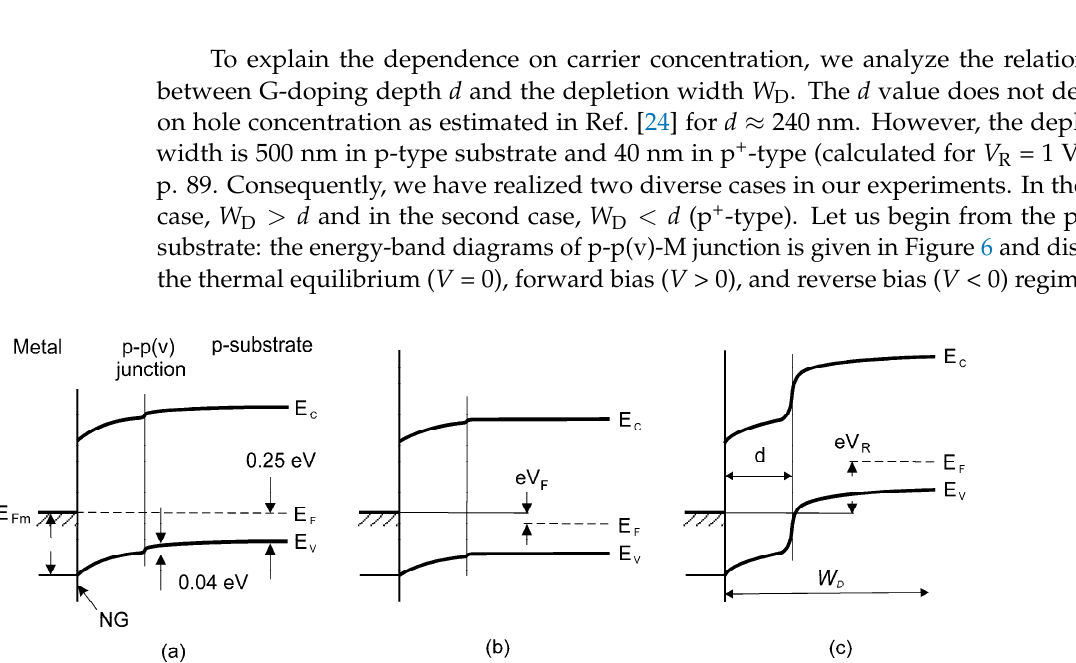
Figure 6. Energy-band diagram of p-p(v)-M junction: ( a ) thermal equilibrium; ( b ) forward bias; ( c ) reverse bias. Distances and energies (except the eV R ) are scaled according to their experimental values.